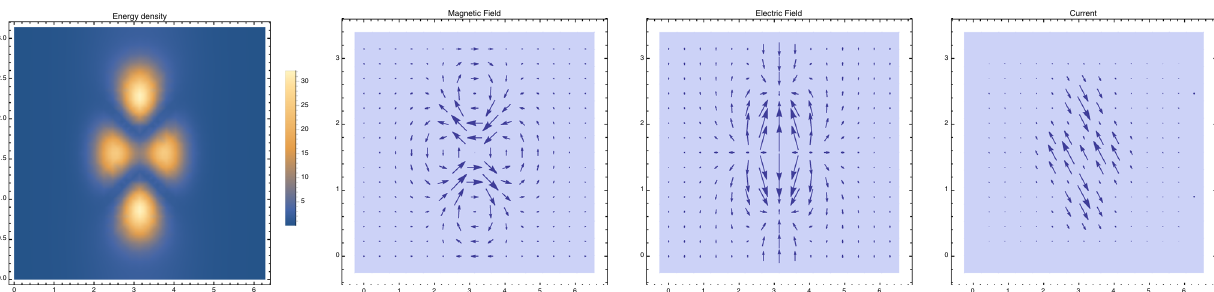
Fig. 1 From left to right we can see the energy density E , the magnetic field, the electric field and the current J μ for a configuration with Baryon charge B = 1. The electric and magnetic fields vanish at the peaks of the energy density while the current takes its maximum value